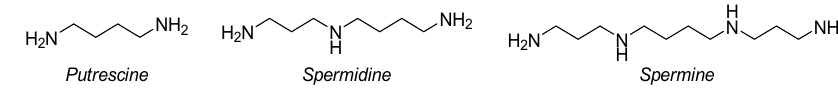
Figure 1. Natural PAs.